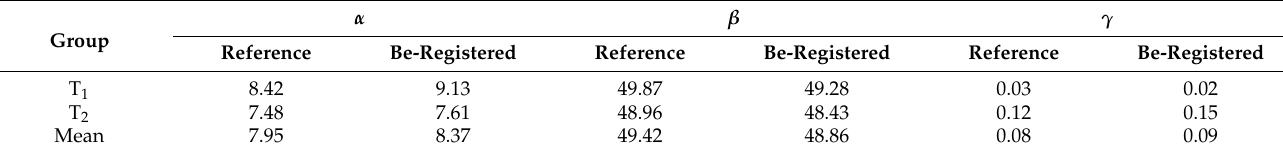
Figure 5. The improved images for T1: ( a ) Reference image; ( b ) Be-registered image. Table 1. Three image quality indexes of T1 and